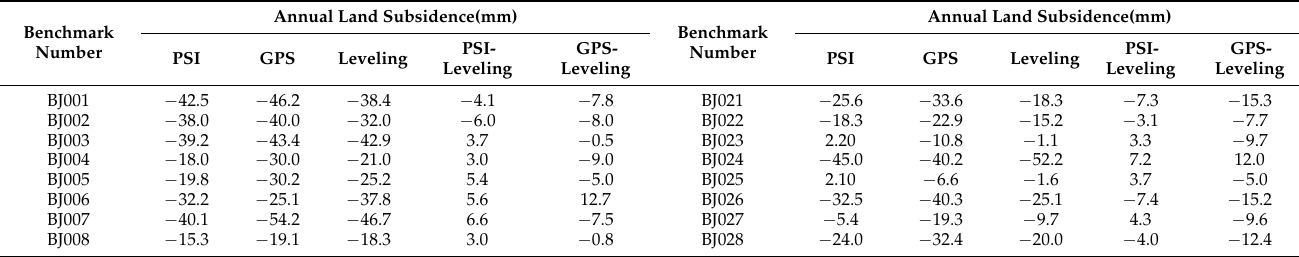
Table 2. Comparison of PSI, GPS vertical deformation, and leveling measurement results. Benchmark